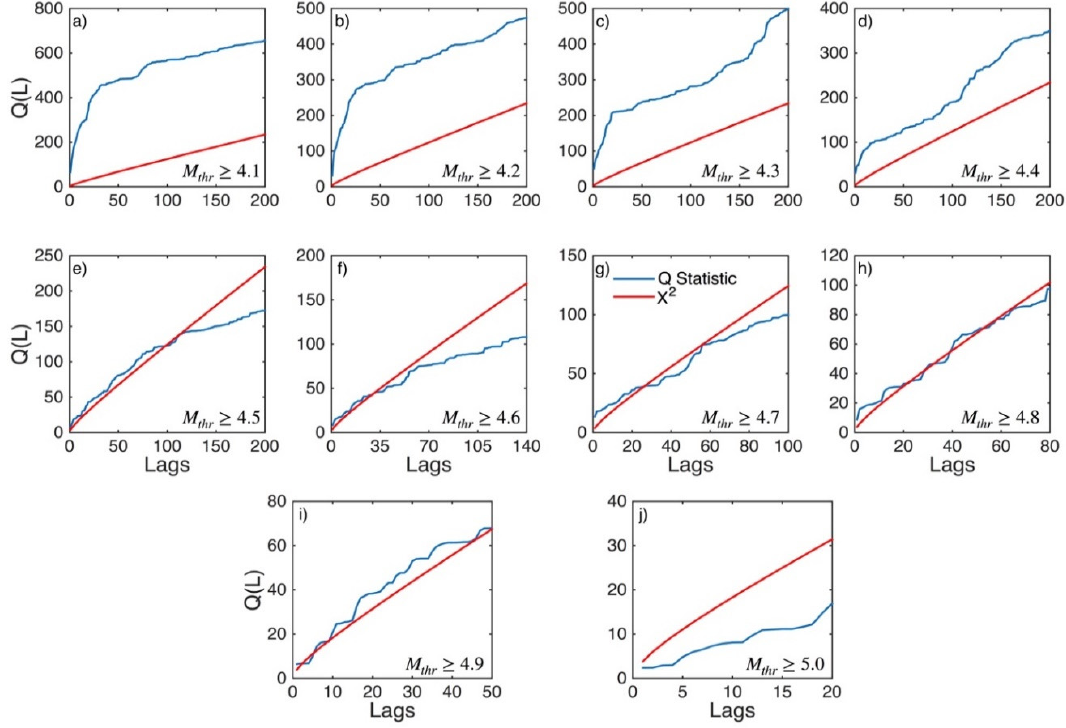
Figure A21. Statistics of Ljung–Box Q-test (blue lines) and the critical values for the X 2 distribution (red lines) for Central Greece (sub-area 8) for magnitude thresholds ( M thr ) varying from 4.1 to 5.0 (subplots a – j ).